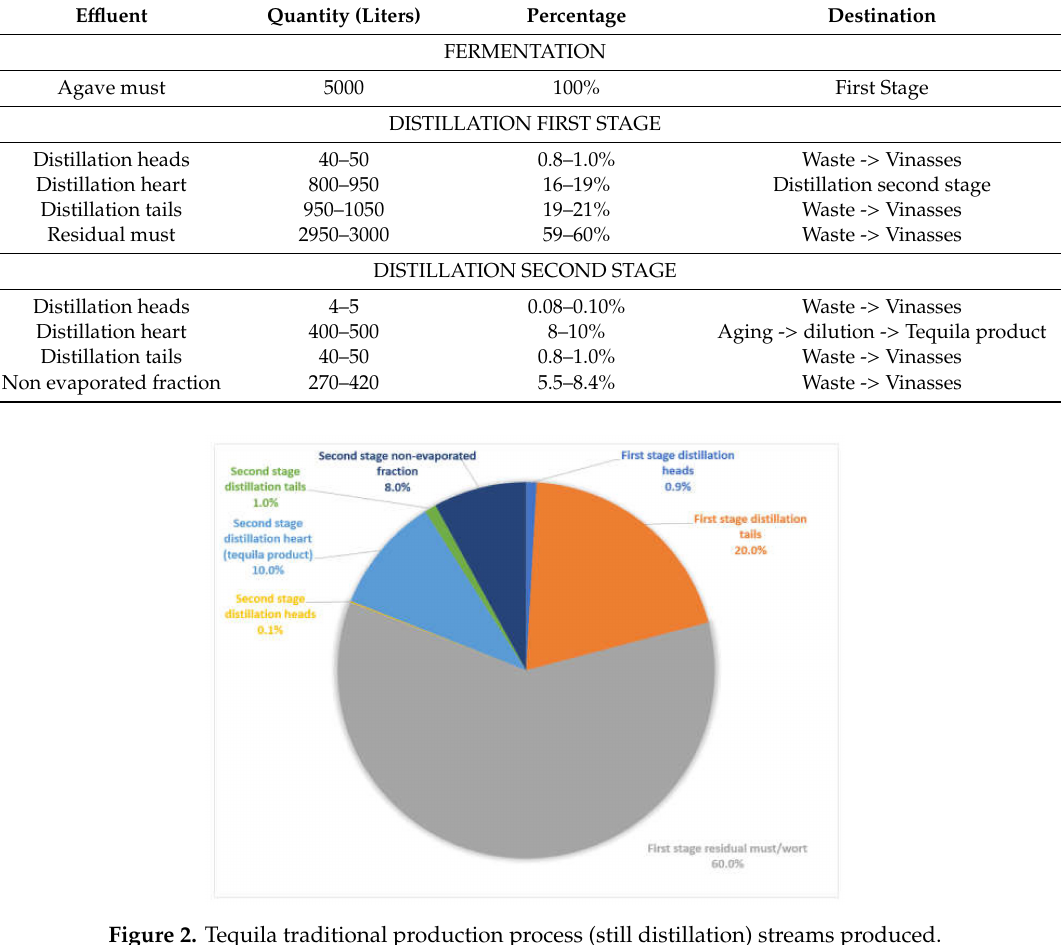
Figure 2. Tequila traditional production process (still distillation) streams